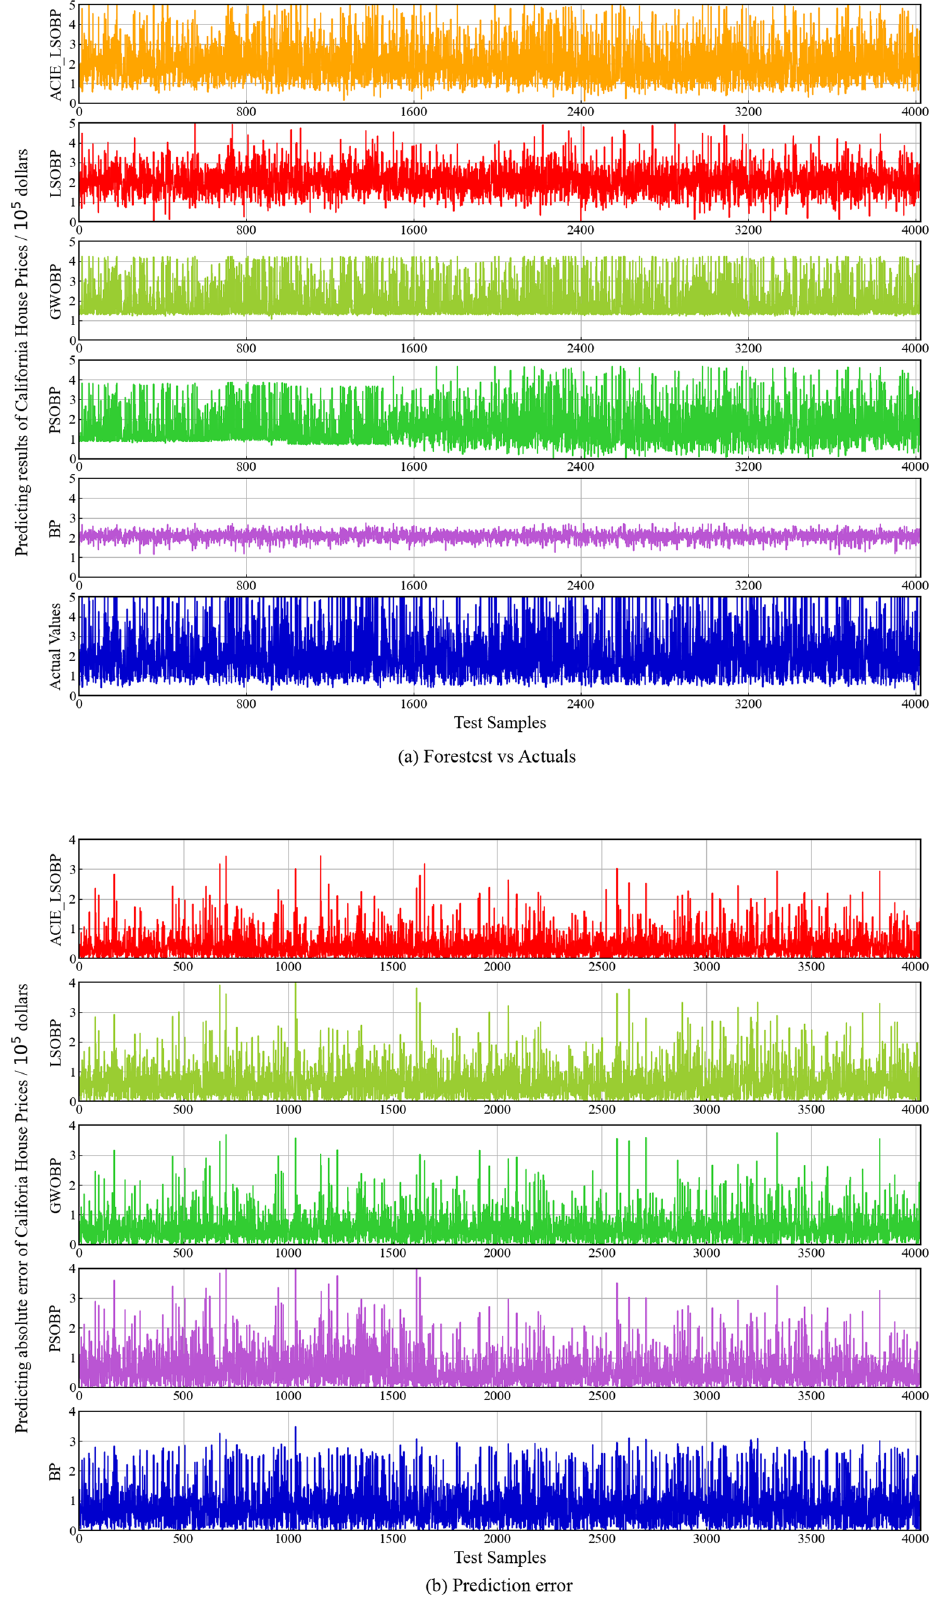
Fig. 6 Comparison of the prediction results of each algorithm on the California test